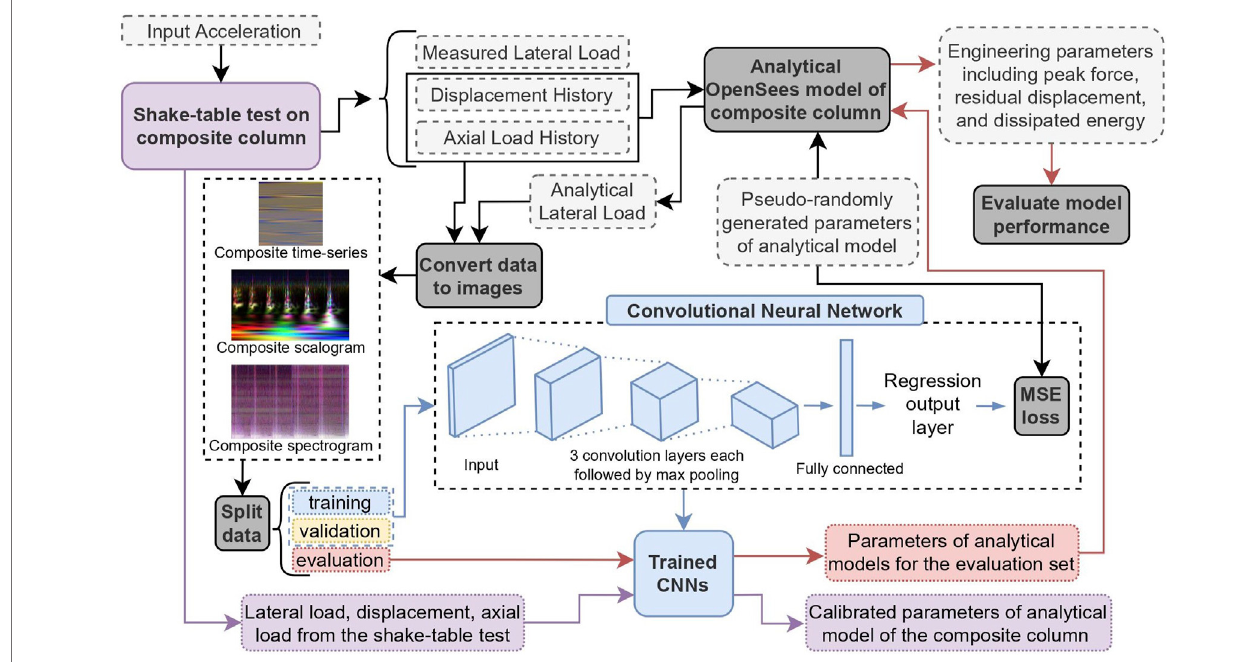
FIGURE 3 | Complete work fl ow of the proposed framework, including generating the training data, evaluating the trained networks using the engineering metrics, and obtaining calibrated parameters for the composite column system.